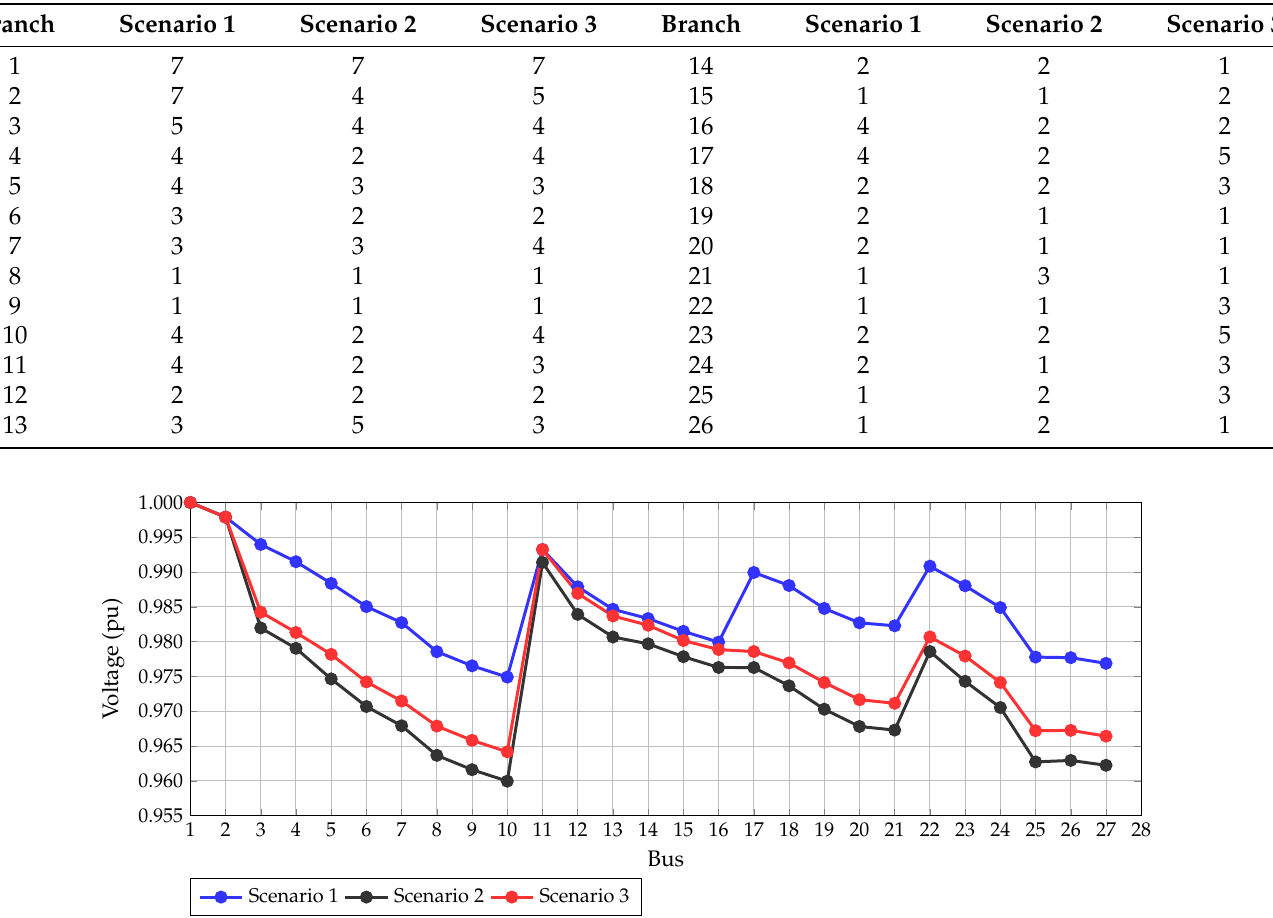
Table 15. Conductor selection test system 2.